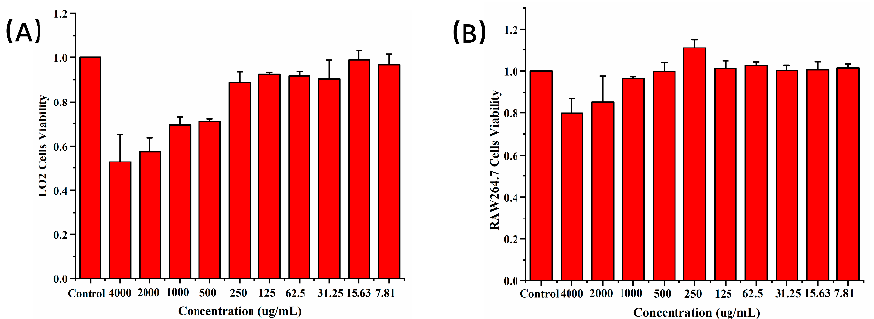
Figure 4. Cell viability results of ( A ) LO2 and ( B ) RAW264.7 after incubation with free PLR-CDs (control) at different concentrations ranging from 7.81 to 4000 μ g/mL for 24 h.